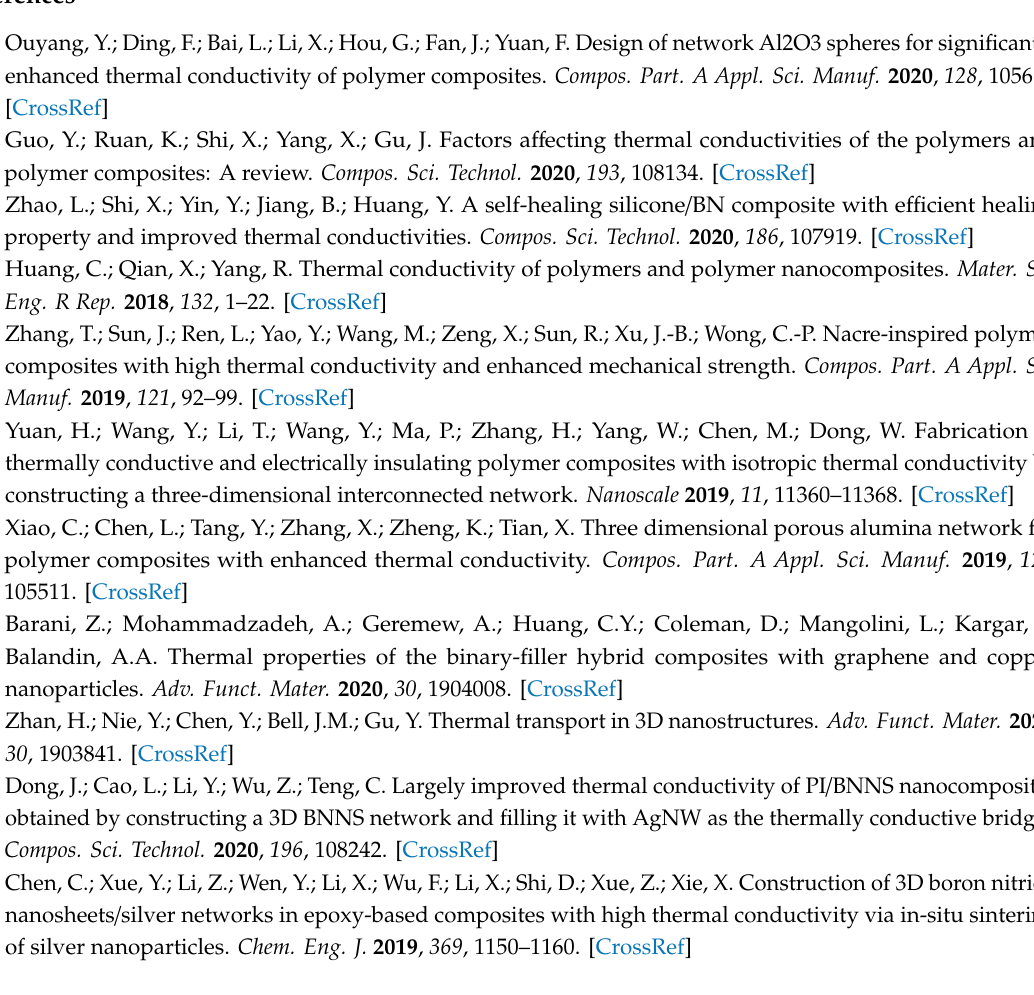
Figure S1: Cross-sectional FE-SEM images of epoxy composites filled with (a) 10%, (b) 20%, (c) 30%, and (d) 40% filler fraction of hybrid filler (1:1 wt ratio), Table S1: Experimental condition for preparation of composites with various fillers, and their measured thermal di ff usivities, Figure S2: Schematic of the composites of #1, #5, #9, and #13 in Table S1, and the thermal di ff usivity enhancement ratio of #1 to #5 and #9 to #13, Figure S3: Thermal conductivity of the composites filled with 40% filler fraction of hybrid filler (1:1 wt ratio), 33% filler fraction of hybrid filler (1:0.5 wt ratio), and 29% filler fraction (1:0.2 wt ratio) of hybrid filler cured at 180 ◦ C and 220 ◦ C, Figure S4: FE-SEM image of over coalesced SAC305 particle in fractured surface of the composite when curing temperature set to 220 ◦ C for 30